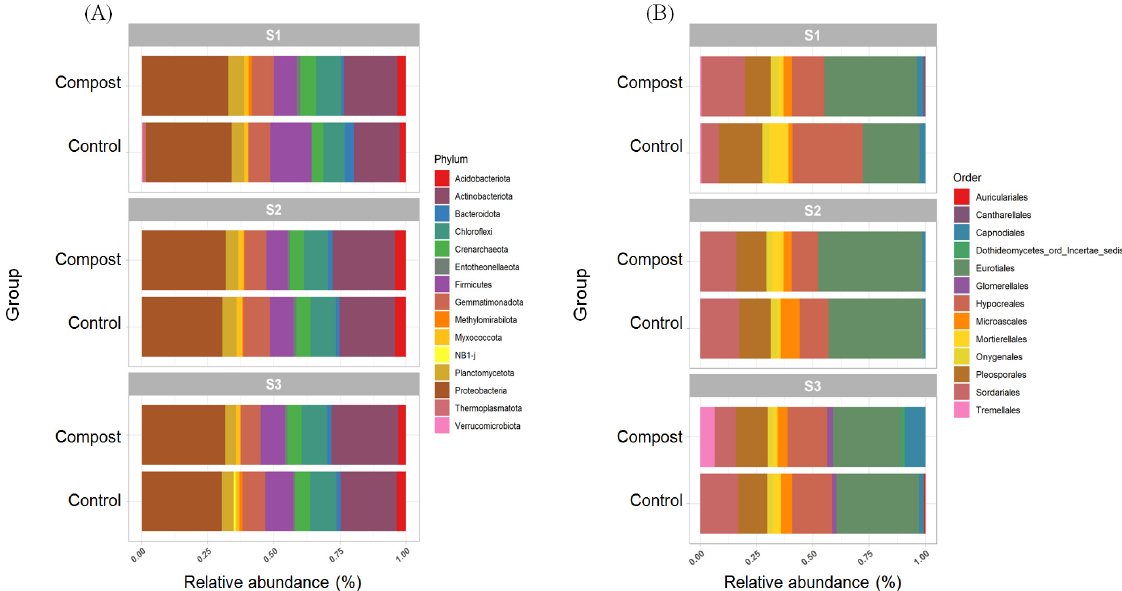
Figure 3. Relative abundance of bacterial phyla ( A ) and fungal orders ( B ) detected in soil after date palm waste compost treatment at tillering (S1), booting (S2) and ripening stage (S3).